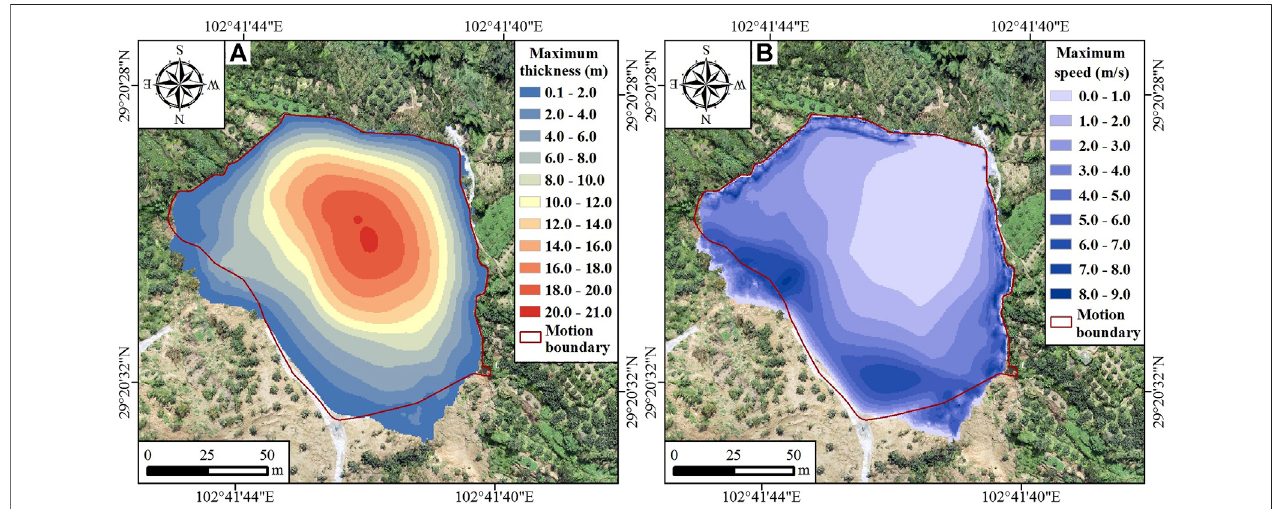
FIGURE 6 | The maximum thickness and speed of the initial landslide during the sliding